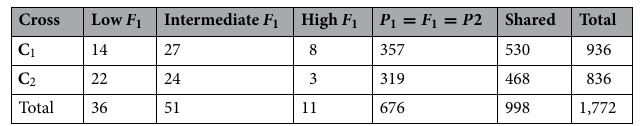
Table 6. Number of GO terms enriched in “Molecular Function” (MF) per class.